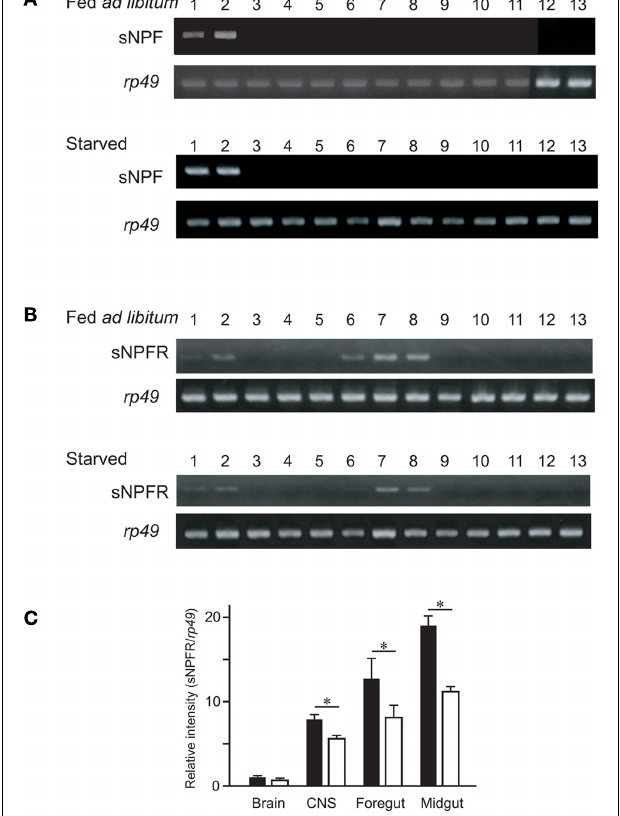
FIGURE 3 | Reverse transcription-polymerase chain reaction analyses of the sNPF precursor and sNPFR (BNGR-A10) in B. mori in ad libitum fed larvae and starved larvae. Tissues were isolated from 2-day-old fifth instar larvae: brain (lane 1), central nervous system (CNS) (lane 2), foregut (lane 3), midgut (anterior, medial, posterior, lanes 4–6), hindgut (lane 7), Malpighian tubules (lane 8), fat body (lane 9), silk glands (lane 10), testis (lane 11), ovary (lane 12), and hemocytes (lane 13). RT-PCR analyses were performed for the sNPF precursor (A) and sNPFR (BNGR-A10) (B) . PCR control consisted of rp 49 amplification. (C) qRT-PCR analyses for sNPFR of brain, CNS, foregut, and midgut. Black and white bars represent relative expression levels of sNPFR compared with rp49 in the larvae fed ad libitum and starved, respectively. N = 5, Mean ± SEM, * P < 0.05, t